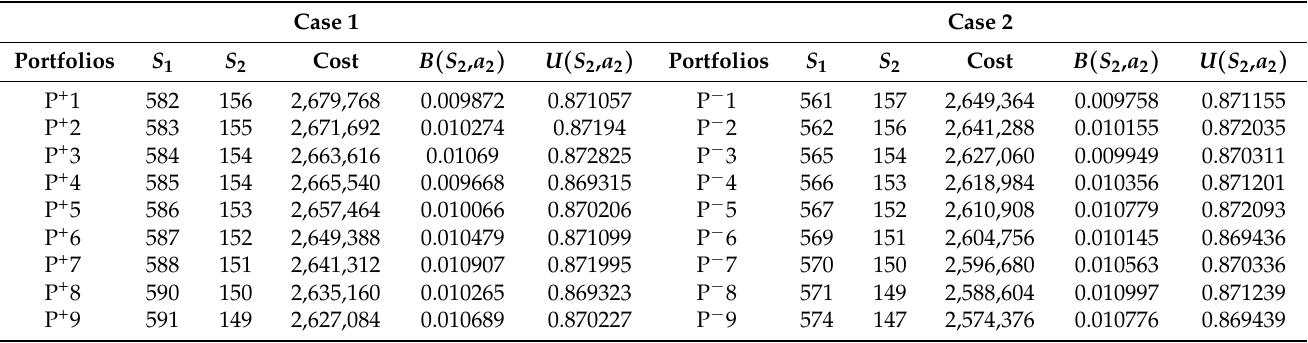
Table 4. Top nine portfolios under ± 5% rate of